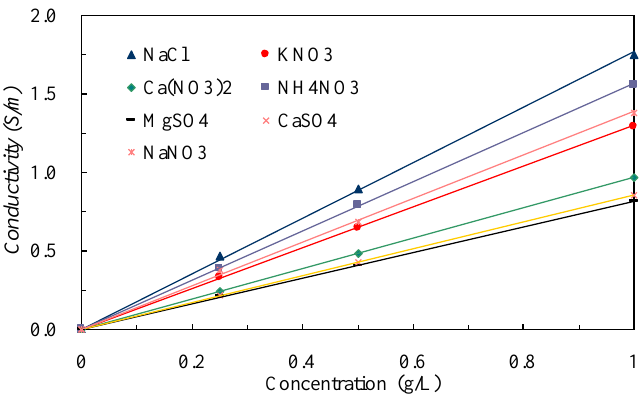
Figure 4. Different soluble constituent volume conductivity performance.